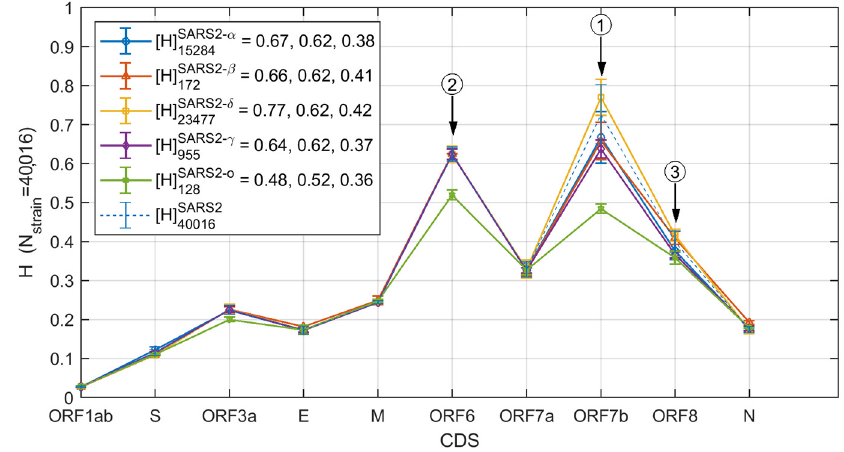
Figure 3. The SARS-CoV-2 Alpha, Beta, Delta, Gamma, and Omicron variants show significant difference in mean HGS values. The HGS values of the top 3 genes (ORF 7b, ORF 6 and ORF 8) are shown in legend for different variants.